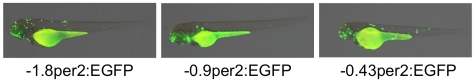
Transient expression of EGFP under the control of the per2 promoter.Representative photographs of 3 day(s) post-fertilization (dpf) microinjected larvae. Left panel: −1.8per2:EGFP construct was microinjected into zebrafish embryos. Ninety-four percent of injected embryos were EGFP-positive, exhibiting robust EGFP expression scattered throughout all tissues. Injection of −0.9per2:EGFP (middle panel) and −0.43per2:EGFP (right panel) embryos resulted in similar percentages of EGFP-positives, expression patterns, and intensities.